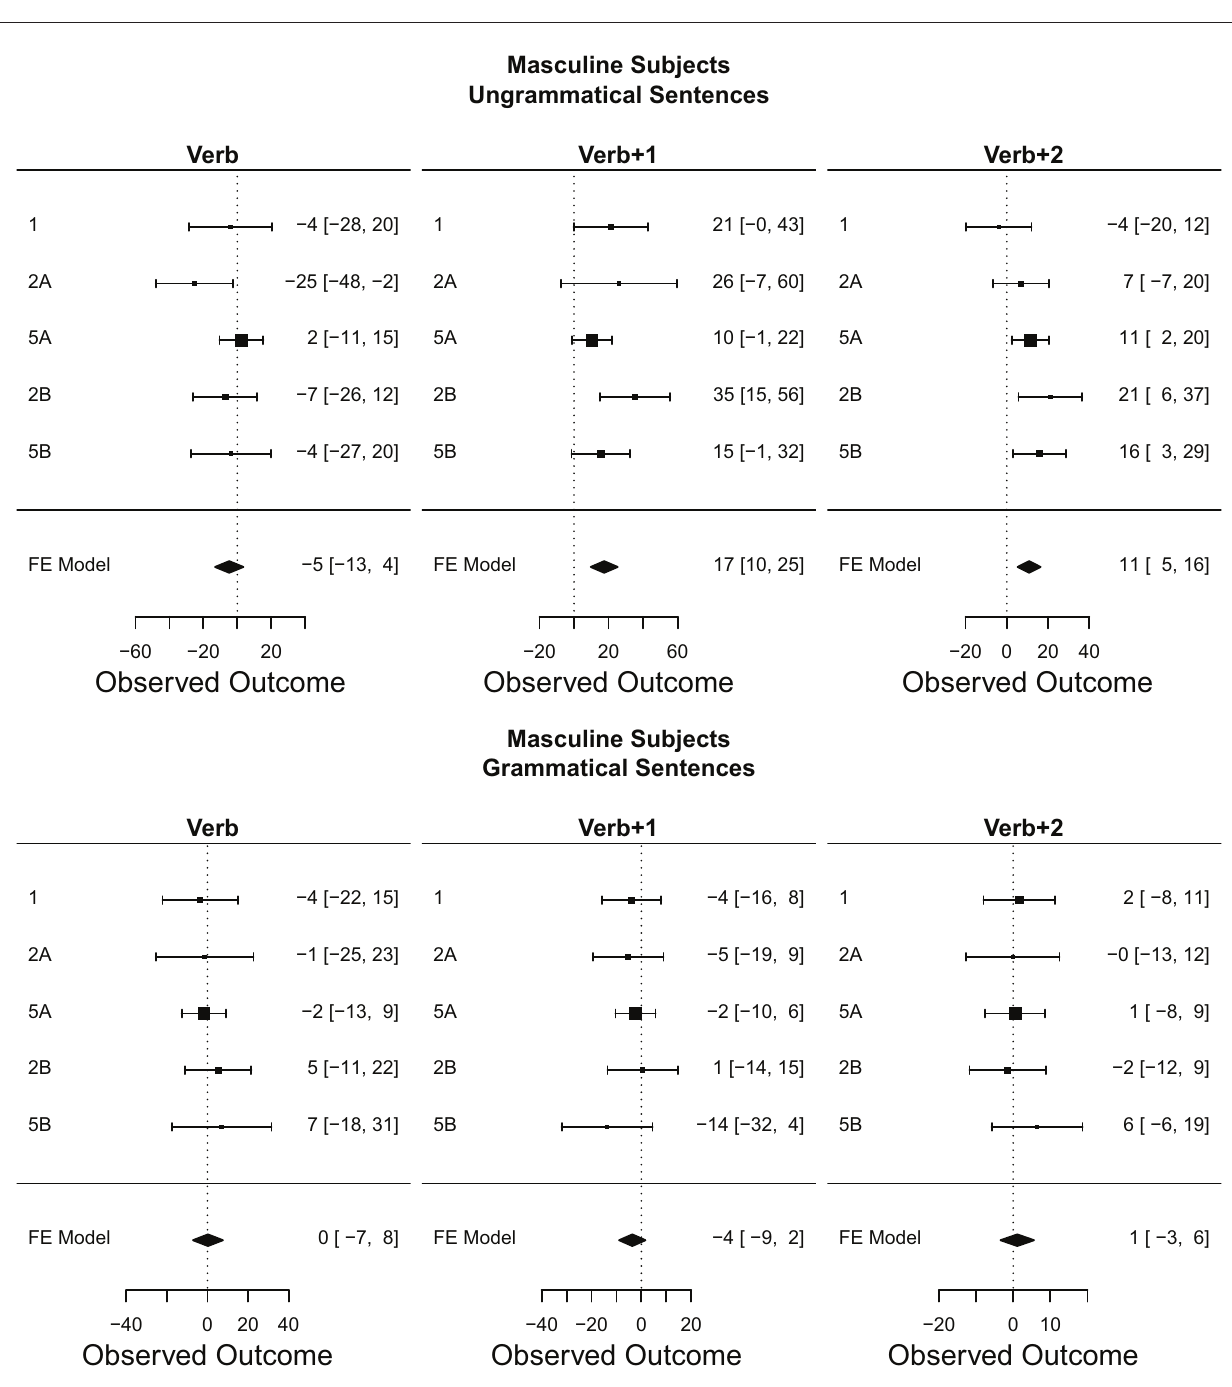
ms, leading to a proportion of 44% between the two